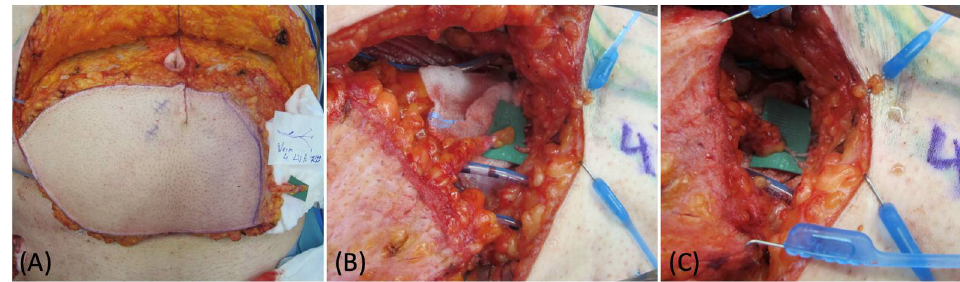
Figure 1. ( A ) DIEP flap harvest with lateral superficial vein isolation. ( B ) Flap preparation at recipient site before and after the LVA ( C ).